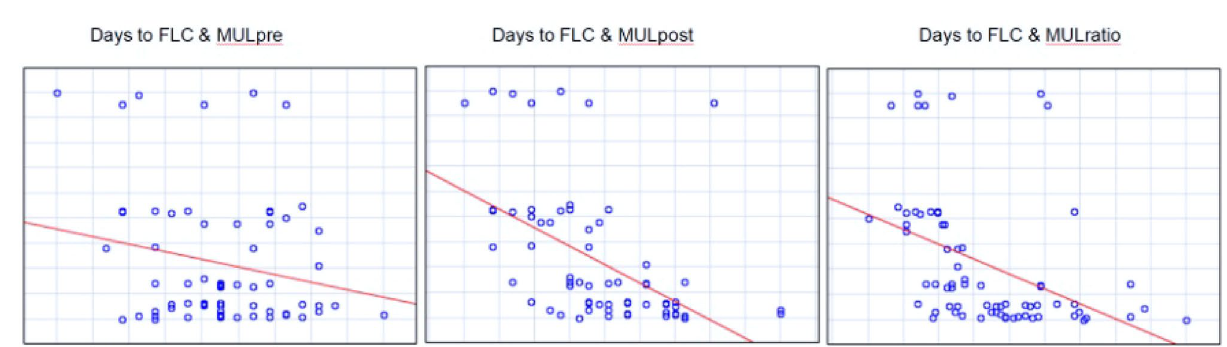
Figure 6. Comparison of percent change in membranous urethra length (MULratio) between subgroups of patients continent and incontinent one and twelve months post laparoscopic radical prostatectomy; (CI 95%, p = 0.00003).